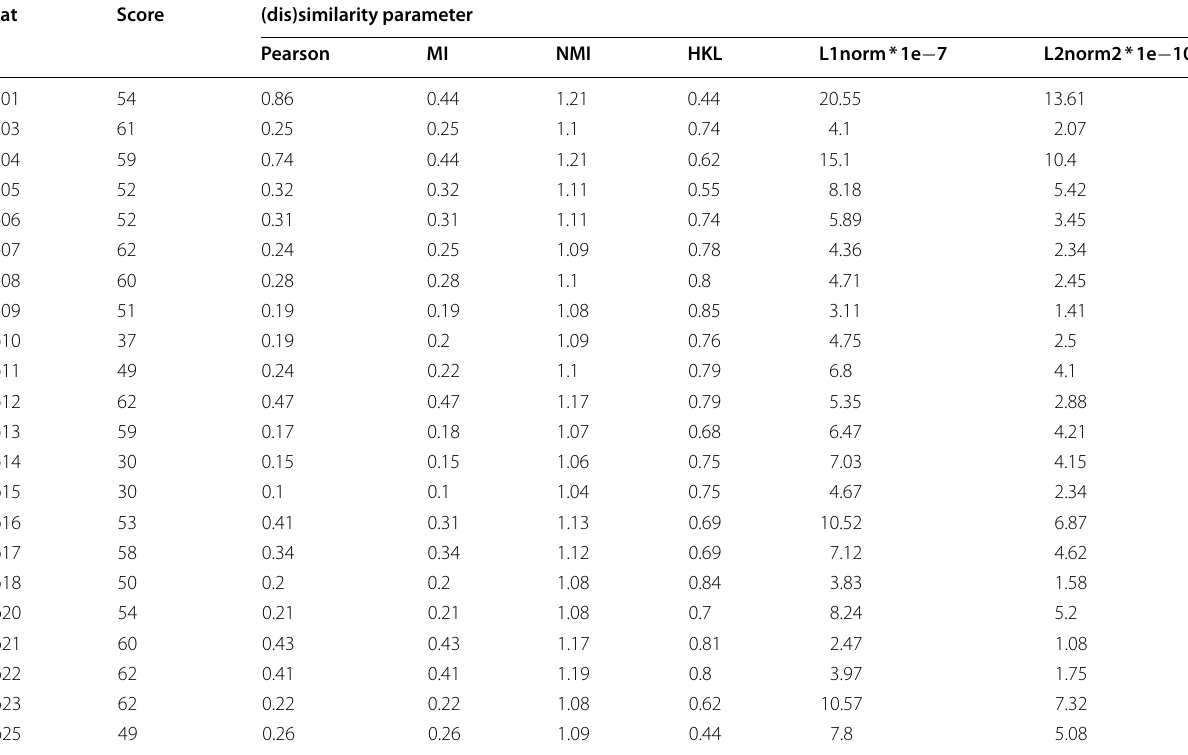
Table 4 Calculated values of the quality of registration (score) and the (dis)similarity parameters of corresponding ldCT and hdCT image pairs in case of γ masking technique (data are rounded to two significant digits)